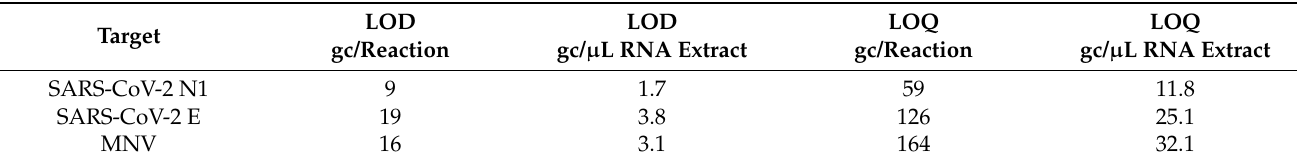
Table 4. Limit of detection (LOD) and limit of quantification (LOQ) for the triplex qRT-PCR assay targeting N1, E gene and MNV.